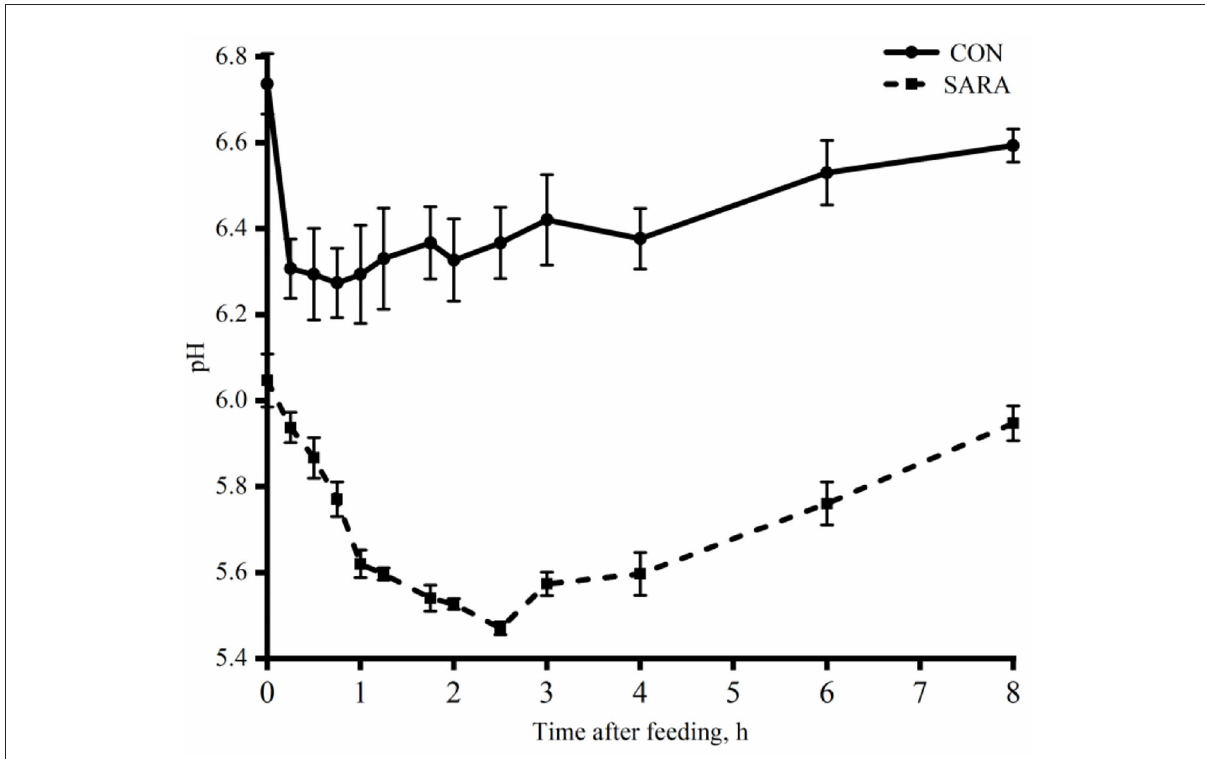
FIGURE1 The dynamic variation of ruminal pH of goats under normal condition (CON) or SARA condition. Data were expressed as mean ± SEM ( n = 6). Diet P < 0.001, Time P < 0.001, Diet* Time P =